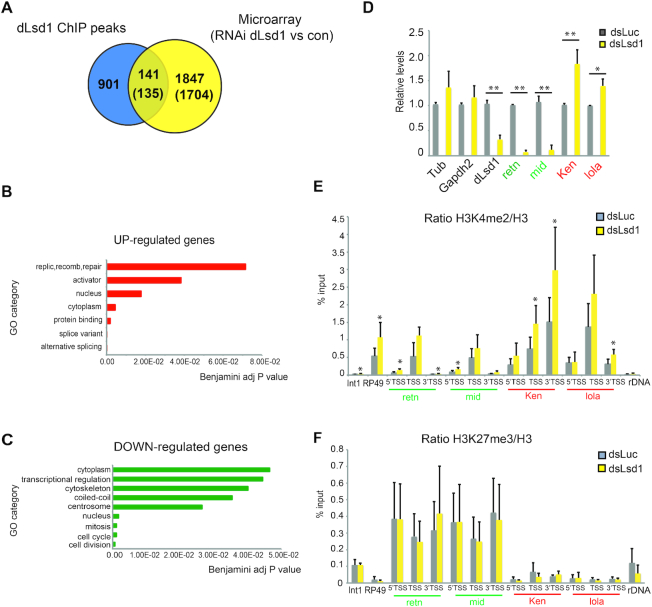
dLsd1 regulates the expression of genes involved in cell cycle and in transcriptional regulation. (A) Venn diagram showing the overlap between dLsd1 ChIP-Seq peaks proximal to the TSS and the genes deregulated upon dLsd1 depletion according to the microarray data (log2 fold change >±0.6, P value <0.05). The numbers in parenthesis represent the total number of genes containing at least one peak (135), and the total number of genes for which at least one transcript is deregulated (1704). (B) Gene Ontology analysis of the genes up-regulated upon dLsd1 depletion and bound by dLsd1. (C) Gene Ontology analysis of the genes down-regulated upon dLsd1 depletion and bound by dLsd1. The terms showed in (B) and (C) are the most significantly enriched terms (Benjamini adjusted P value <0.1) generated from an analysis with DAVID. (D) RT-qPCR analysis of the expression of four dLsd1 targets in S2 cells upon dLsd1 depletion. Tubulin and gapdh2 are two housekeeping genes used as controls. The expression levels are normalized against S2 cells incubated with dsLuciferase. Experiments were performed in triplicate and error bars indicate the standard error of the mean. A Wilcoxon test was performed to indicate significance (*P < 0.05, **P < 0.01). (E, F) Cross-linked chromatin was isolated from S2 cells incubated with dsRNA against dLsd1 or Luciferase (control), and ChIP analysis was performed using antibodies specific for H3, H3K4me2 and H3K27me3. The ratio between total H3 and each antibody is shown. 5′TSS, TSS and 3′TSS indicate the position of the primers relative to the TSS, with 5′ being upstream and 3′ being downstream of the TSS. Experiments were performed at least in triplicate and error bars indicate standard deviation. A Wilcoxon test was performed to indicate significance (*P < 0.05; **P < 0.01).